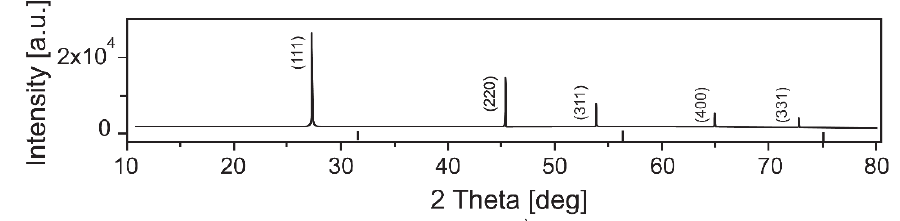
Figure 1. XRD pattern of pure ZnSe.